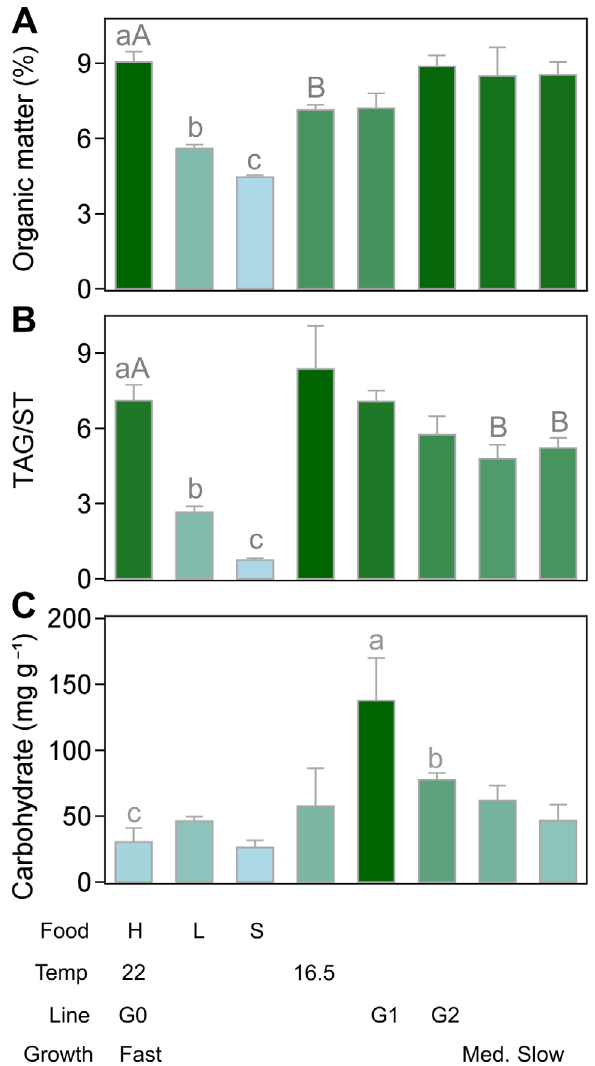
Fig. 6. Organic matter (% of total body mass), lipid reserves (triacylglycerol:sterol ratio, TAG:ST) and carbohydrate con- tent (mg per g of organic matter) measured at the end of the acclimation period, before the exposure to the virus. Analy- ses were conducted on a subset of the samples to investigate main effects only (no interaction). Fast-growing G0 oysters held at 22°C and fed ad libitum (high food level, H) were used as a reference and compared to their counterparts ex- posed to low food (L) or starved (S), held at 16.5°C, from G1 and G2 and with medium and slow growth rate, everything else being equal. Lowercase letters indicate significant differences, and capitalization distinguishes effects when 2 factors were significant. G: